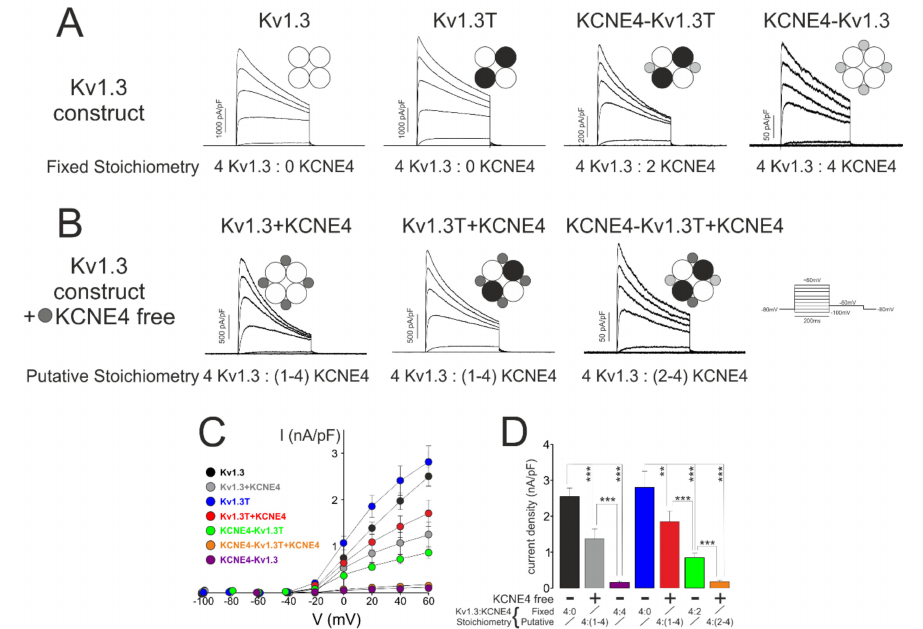
Figure 3. Current density versus voltage of K + currents. HEK-293 cells were transfected with di ff erent Kv1.3-KCNE4 constructs, and the K + currents were analyzed. Cells were clamped at − 80 mV,